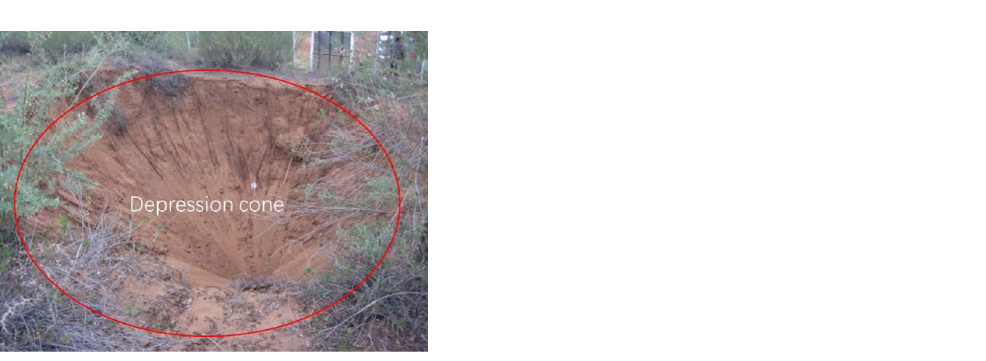
Figure 3. Depression cone on the surface.